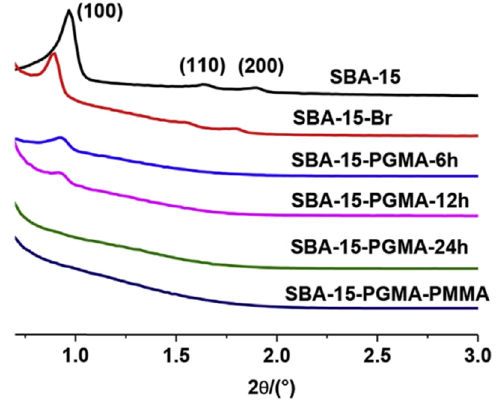
Figure 11: XRD patterns of SBA - 15 and its composites [ 74 ] ; Copy - right: 2018 with permission from Elsevier Science BV.